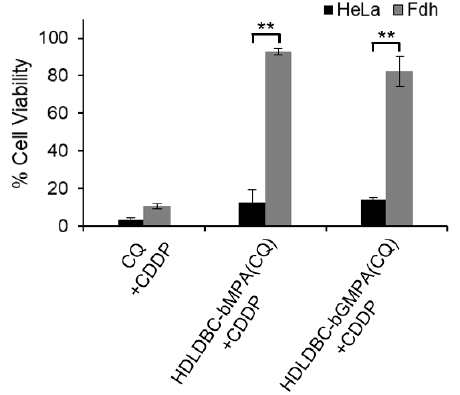
Figure 8. Cell viability after the simultaneous treatment with CQ and CDDP on HeLa and Fdh. Cells were incubated with 40 µ M of free CQ or CQ encapsulated in HDLDBC-bMPA and 1 µ g/mL of free CDDP during 72 h (** p < 0.01).